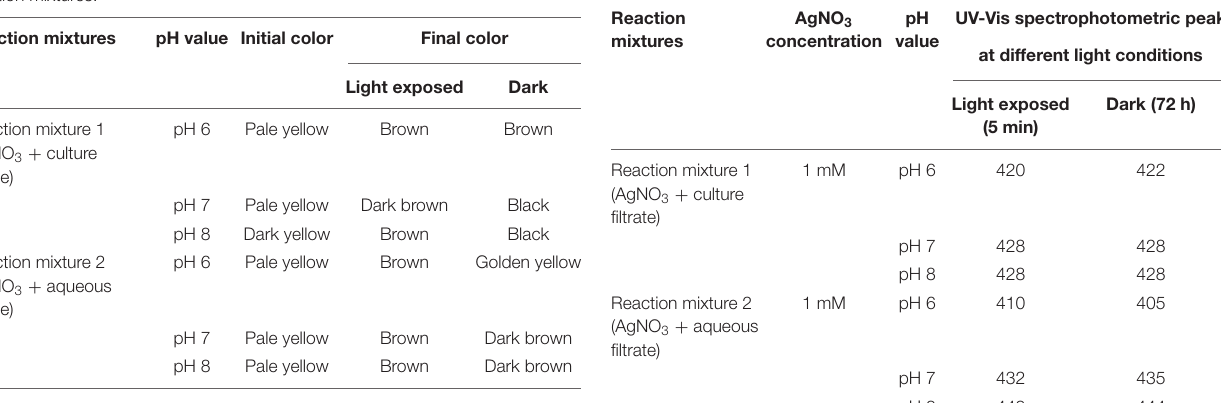
TABLE 2 | UV-Vis (visible) spectrophotometric peaks at different light